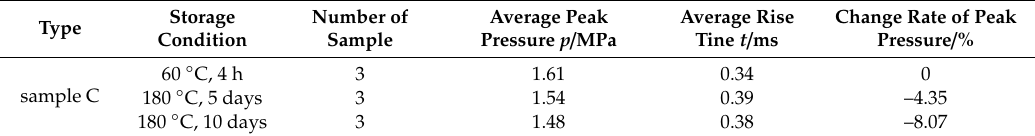
Figure 13. P -t curves of sample C before and after storage at 180 °C. Table 4. Mean values of characteristic parameters of the P - t curve of sample C after the 180 °C test.